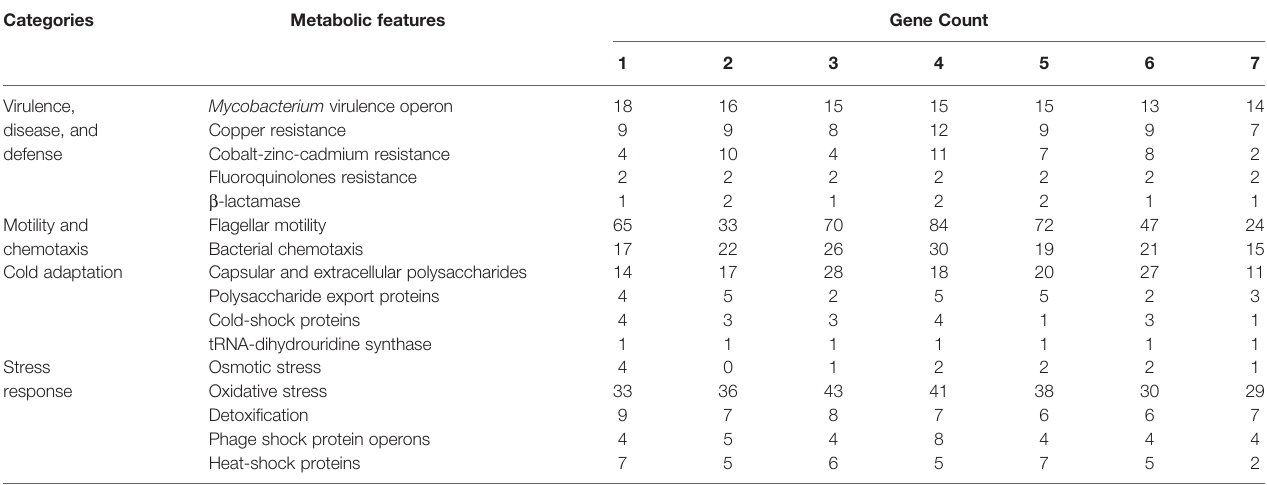
FIGURE 6 | Histogram of predicted carbohydrate-active enzymes in strains A6E486 T , 5E331 T , K. gwangyangensis JCM 30877 T , K. lipolytica JCM 12864 T , K. lacus CGMCC 1.9109 T , K. pumila N18 T , and K. sediminis KCTC 42590 T . Numbers of each enzyme detected in the genomes were shown in the map. GT, glycosyltransferase; GH, glycoside hydrolase; CE, carbohydrate esterase; CBM, carbohydrate-binding module; AA, auxiliary activity; PL, polysaccharide under anaerobic conditions, and nitrate is reduced to nitrite. The activities of trypsin and oxidase are positive, and the activities of ɑ -chymotrypsin, ɑ -galactosidase, ɑ -glucosidase, ɑ -mannosidase, and ɑ -fucosidase are weakly positive. Acids are produced from D - arabinose, D -ribose, D -xylose, L -sorbose, D -tagatose, and potassium 5-ketogluconate. The major cellular fatty acids (>10%) are iso-C 15:0 , iso-C 17:0 , iso-C 17:1 w 9c, and summed feature 3 (comprising C 16:1 w 6c and/or C 16:1 w 7c). The predominant respiratory quinone is Q-10. The major polar lipids consist of PE, PG, DPG, and unidenti fi ed glycolipids, aminolipids, and lipids. The DNA G+C content of type strain is 59.9 mol%. TABLE 4 | Metabolic features and selected genes related to the adaptation to marine environments.